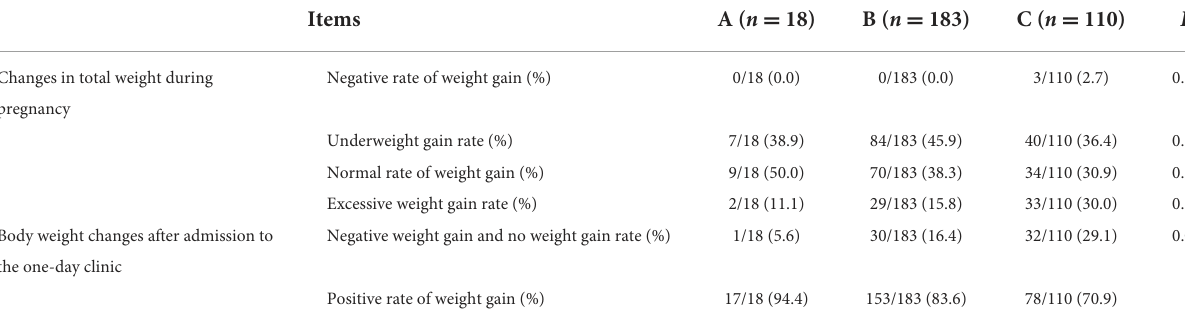
TABLE 4 Comparison of body weight changes among the three groups (X ±